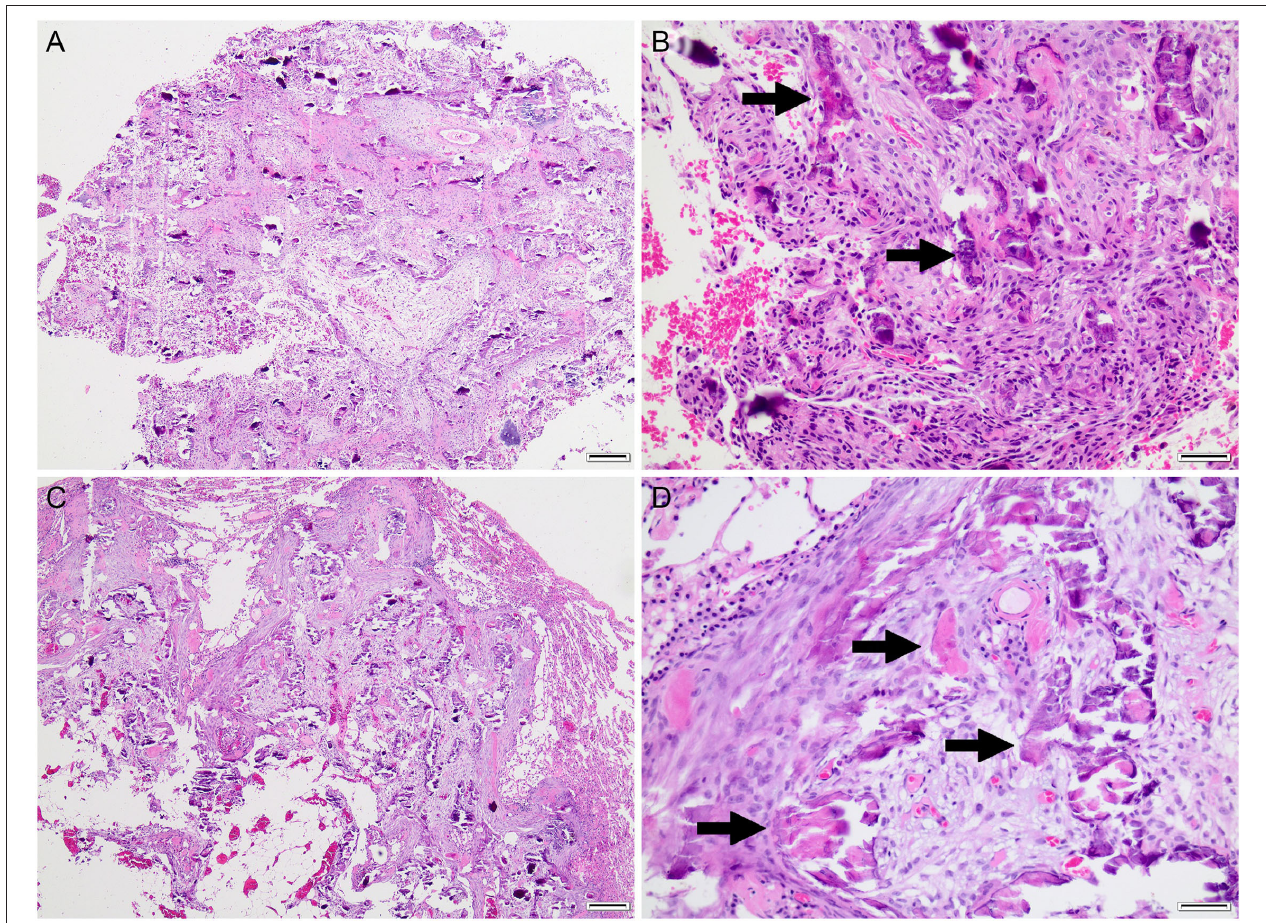
FIGURE 2 | Histopathology of the right elbow mass (A,B) and pulmonary mass (C,D) . Both masses consisted of dense streaming bundles of mesenchymal cells interspersed with trabeculae of mineralized osteoid matrix (arrows) with scant woven bone and variable cartilaginous matrix (not shown). Hematoxylin and eosin. (A,C) , bar = 200 µ m. (B,C) , bar = 50 µ